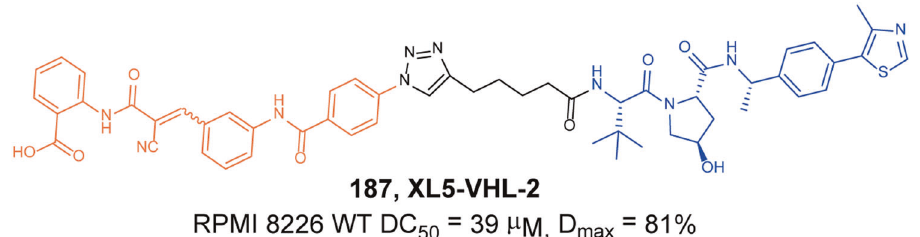
Fig. 50 The representative PROTAC targeting hRpn13 Pru